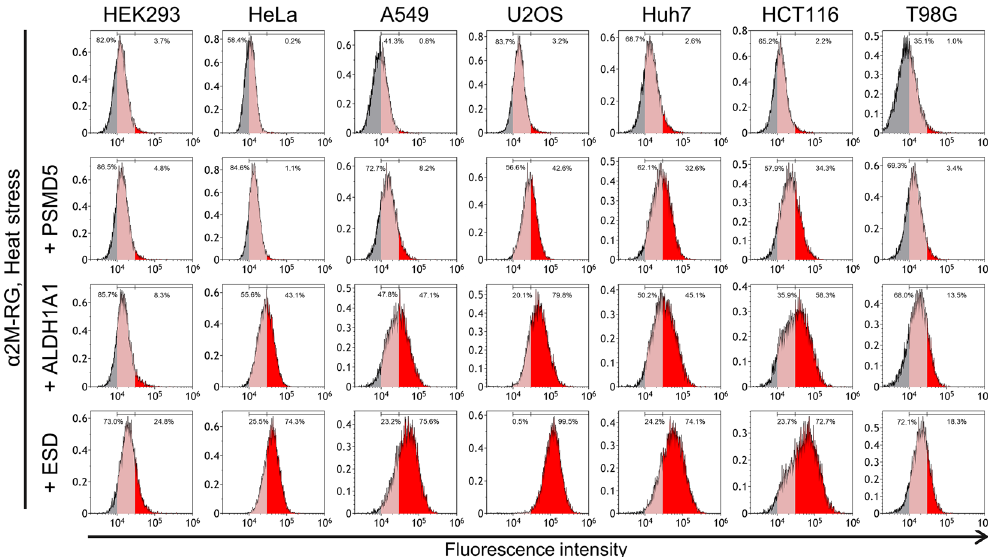
Figure 3. Lysosomal degradation of α 2 M with substrate is ubiquitous in different cell lines. α 2 M–RG internalization assay with PSMD5, ALDH1A1, or ESD. In the absence or presence of substrate, α 2 M–RG was heat-shocked in serum-free medium at 50 °C for 1 h. Each cell line (HEK293, HeLa, A549, U2OS, Huh7, HCT116, or T98G) was cultured in medium for 17 h at 37 °C, then analyzed using flow cytometry (n =